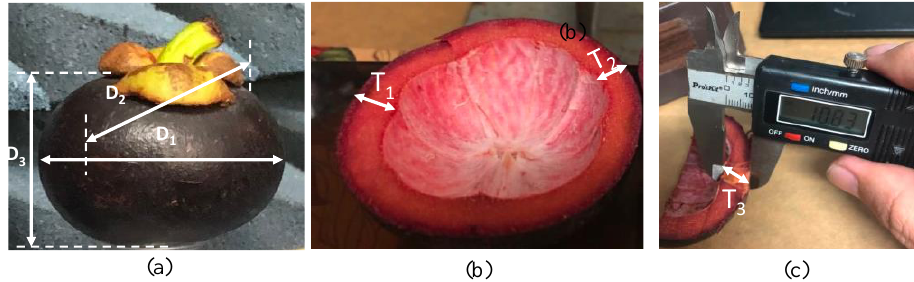
Figure 12. Physical dimensions of mangosteen fruit; ( a ) Outer diameter measurement; ( b ) Thickness of peel around the fruit; ( c ) Thickness of peel at the bottom side of the fruit. The dielectric properties of mangosteen fruits were measured with the dielectric probe. It was found that the translucent flesh had ε (cid:48) r and ε (cid:48)(cid:48) r of 46.9 ± 1 and 28.1 ± 0.2, respectively. The corresponding values for normal flesh were 41.1 ± 4 and 25.6 ± 2.5, respectively. For peel, the values of ε (cid:48) r and ε (cid:48)(cid:48) r were quite constant at 6.4 and 2.1. The dielectric constant, ε (cid:48) r , and loss factor, ε (cid:48)(cid:48) r , of the translucent flesh were higher than the one of the normal flesh. The large variation of the dielectric constant, ∆ ε (cid:48) r = 5.8 and the loss factor, ∆ ε (cid:48)(cid:48) r = 2.5 were observed. Therefore, the dielectric properties of